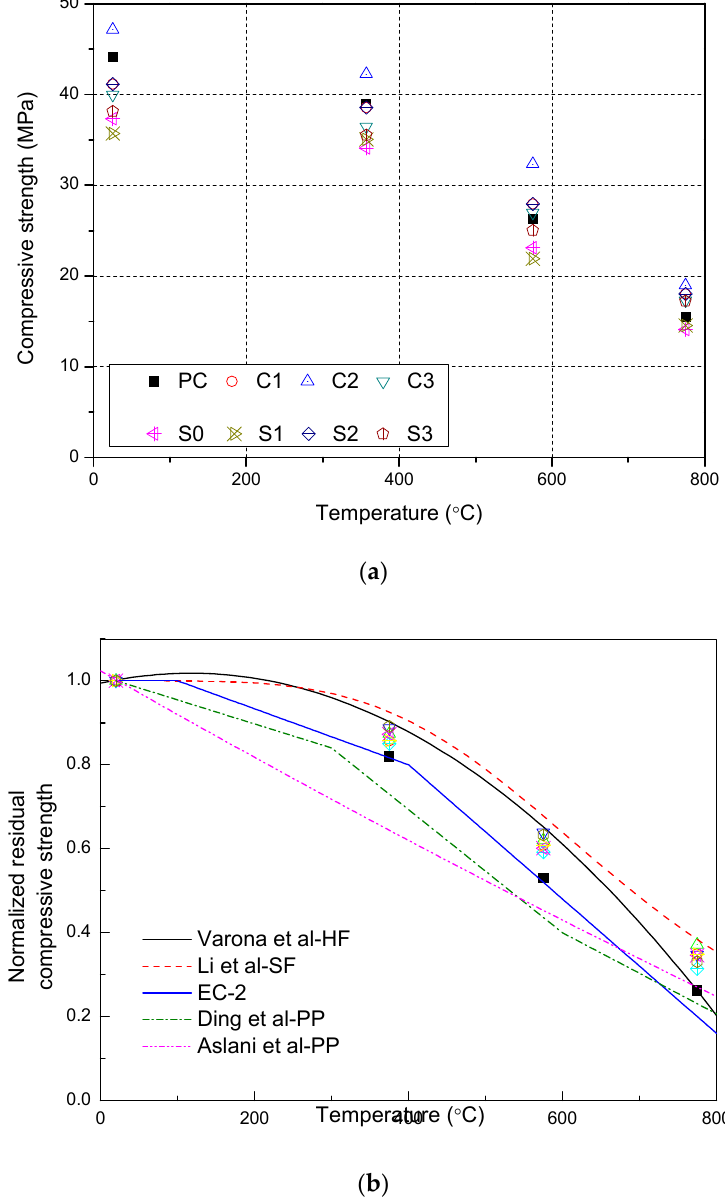
Figure 4. Evolution of the NSCFRC compressive strength after high temperatures; ( a ) The residual compressive strength after exposure to high temperature; ( b ) The normalized residual compressive strength after exposure to high